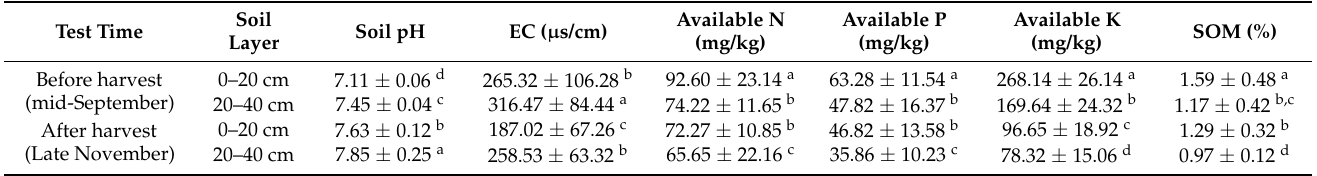
Table 1. Before (mid-September) and after harvest (late-November), the basic physical and chemical properties of soil samples of different soil layers (0–20 cm and 20–40 cm) were measured, including pH value, electrical conductivity (EC) value, available nitrogen (N) content, available phosphorus (P) content, available potassium (K) content and soil organic matter (SOM)